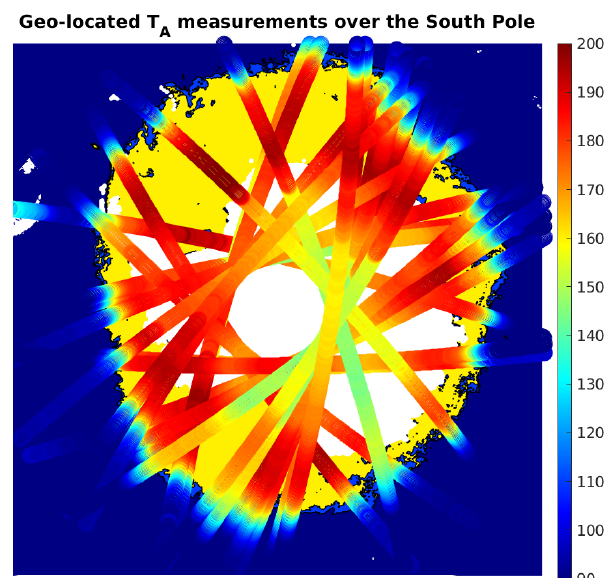
Figure 5. FMPL-2 calibrated antenna temperature ( T A ) (K) over the South Pole overlaid with OSISAF SIE product (in yellow at the background).